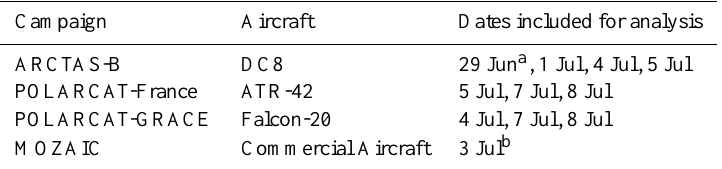
Table 1. POLARCAT flights included for analysis.